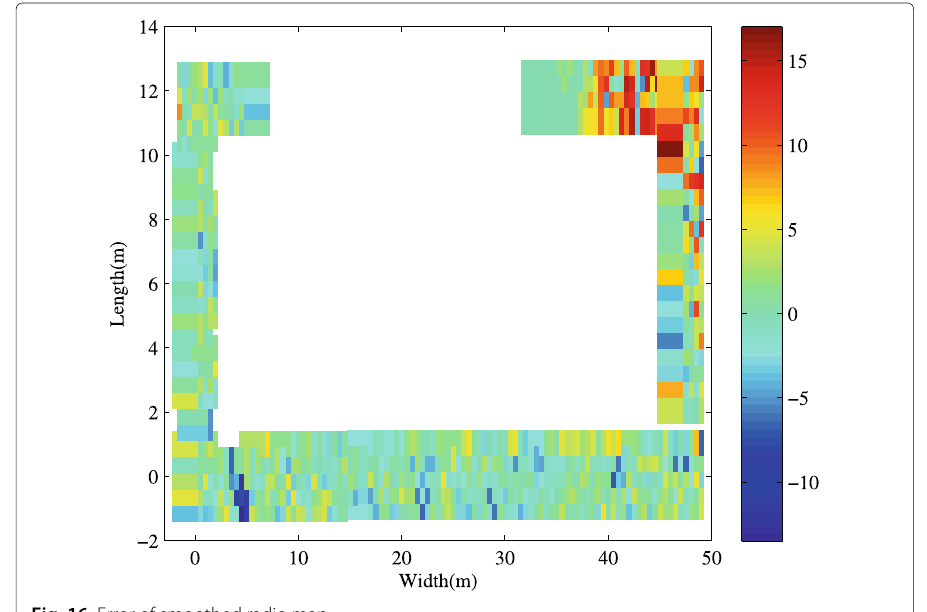
Fig. 16 Error of smoothed radio